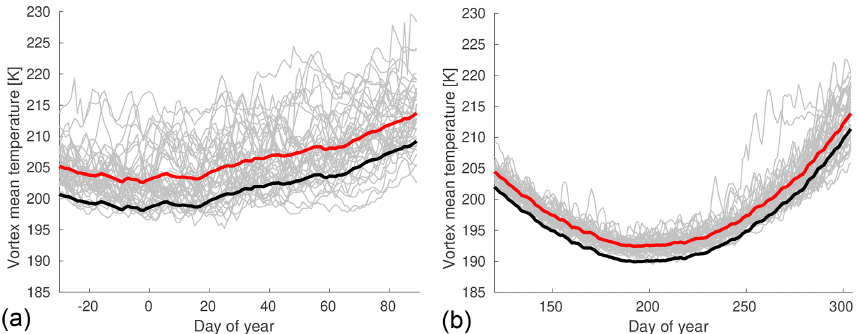
Figure 3. Vortex mean temperatures at 54hPa as a function of day of year for all individual years from 1979/1980 to 2020/2021 (Northern Hemisphere, a ) or 1980–2021 (Southern Hemisphere, b ) based on ERA5 (gray lines), vortex mean temperature averaged over all years (red) and the same curve shifted by − 4 . 5 or − 2 . 5K as an approximation of the lower envelope of the gray lines (black).